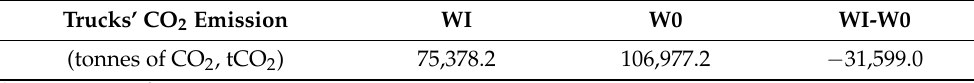
Table 6. Trucks’ traffic savings in the emission of CO 2 (in equivalent tonnes tCO 2